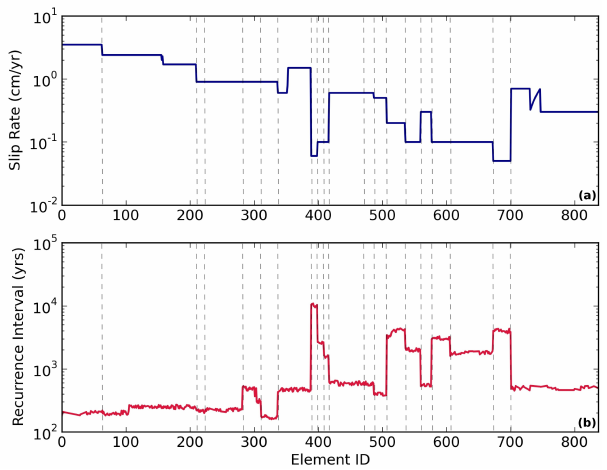
Fig. 3. (a) Prescribed slip rates on each element. (b) Prescribed recurrence intervals on each element.